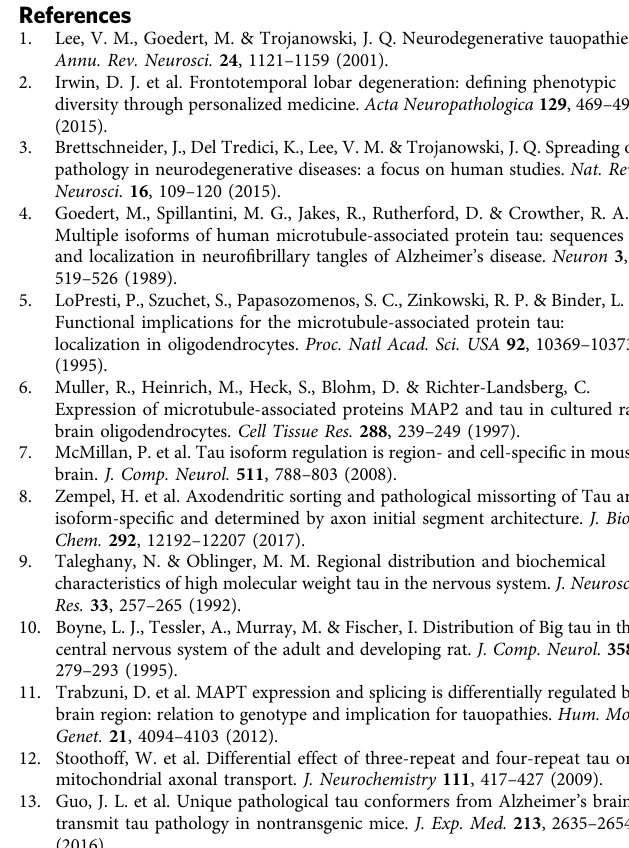
Fig. 9 Distinct tau strains harbored distinct conformations. a Representative immunostaining with anti-hyperphosphorylated tau MAb AT8, the β -sheet amyloid dye Thio fl avin S and nuclear DAPI stain on brain sections from: upper panel, the different human tauopathy brains used for extracting human tau strains; middle and lower panels, the AD_, PiD_, CBD_ and PSP_P0-6hTau mice at 3 and 6 m.p.i., respectively. Purple frame inserts show the Thio fl avin S staining in white frame areas. Scale bars in the purple frames represent 5 μ m. The differences in the amounts of β -sheet structure indicated by the percentage of Thio fl avin S-positive pathologies in 6hTau mice injected with distinct human tau strains at two different time points were quanti fi ed in b . Data are presented as mean ± s.e.m. n = 3 – 6 for each group, with each dot representing a mouse. One-way ANOVA with Sidak ’ s multiple